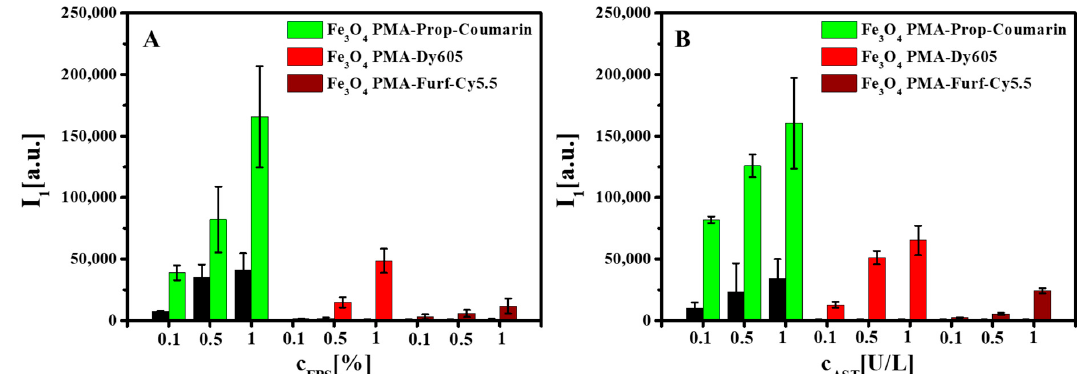
Figure 3. Effect of enzyme concentration on the number of released dye molecules and polymer fragments from the polymer upon enzymatic digestion due to ( A ) FBS and ( B ) AST as presented for Fe 3 O 4 PMA-Prop-Coumarin NPs, Fe 3 O 4 PMA-Dy605 NPs, and Fe 3 O 4 PMA-Furf-Cy5.5 NPs. The black control data refer to control solutions in which the enzymes, but no NPs, were present, after ultrafiltration.